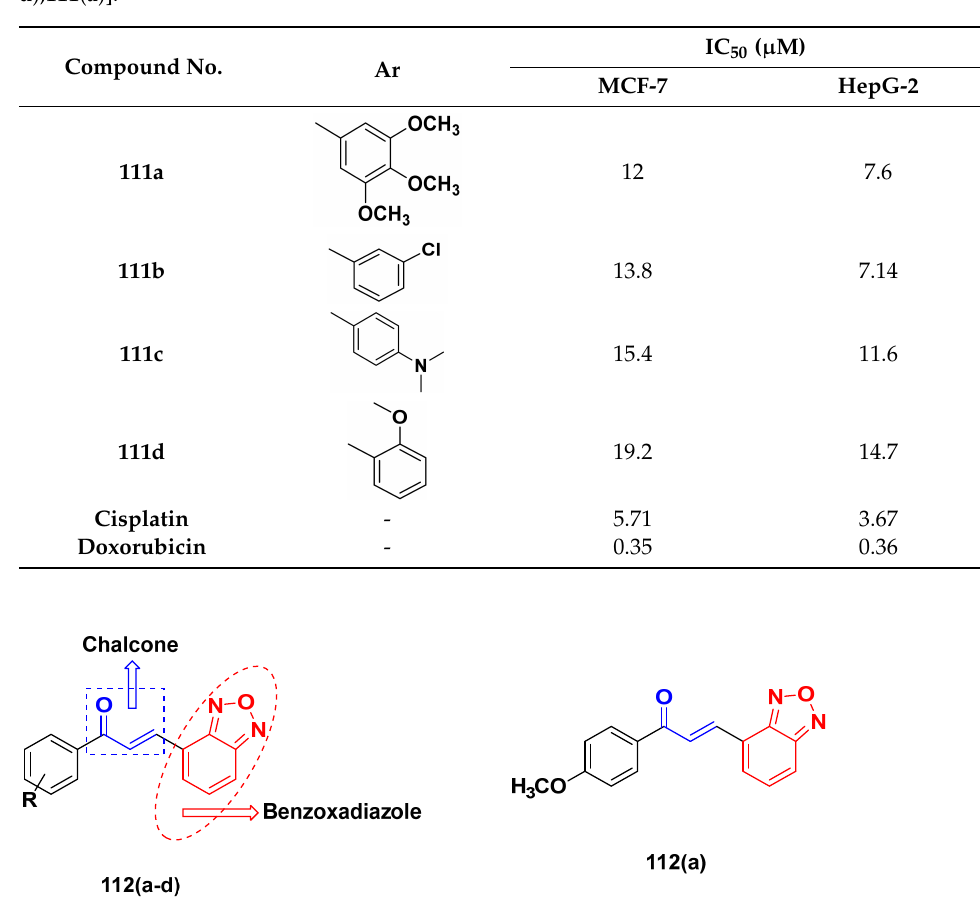
Table 93. In vitro cytotoxic activities of chalcone ‐ based phenothiazine hybrid compounds [ 111 ( a – d ), 111 ( a )].